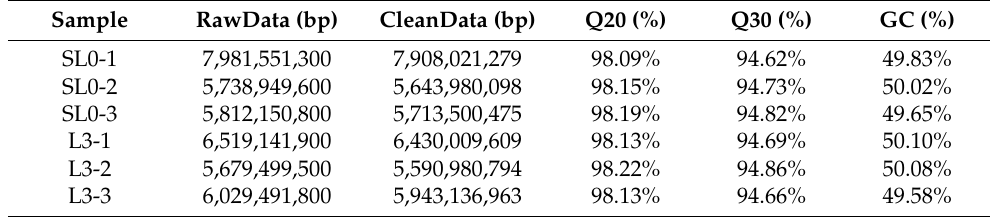
Table 6. Information of the transcriptomic read of each sample.